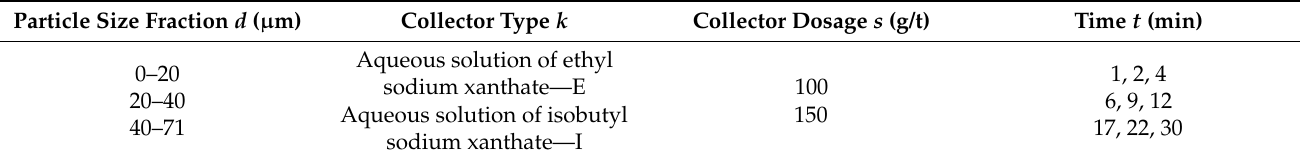
Table 2. Characteristics of adjustable factors.